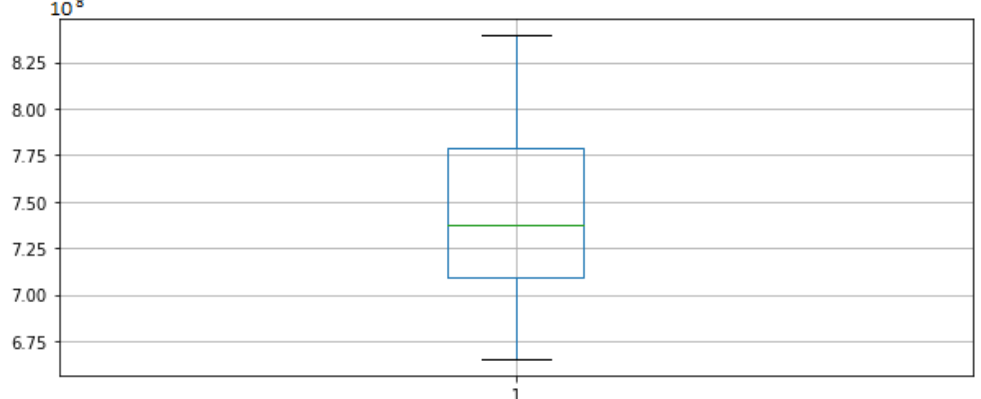
Figure 18. All 10 runs on Belgium 2017 dataset, magnified.